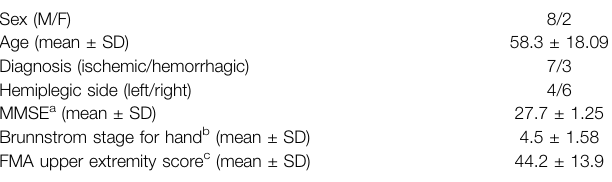
TABLE 1 | Stroke participant characteristics. TABLE 2 | Questionnaire for Serious-Games Rehabilitation